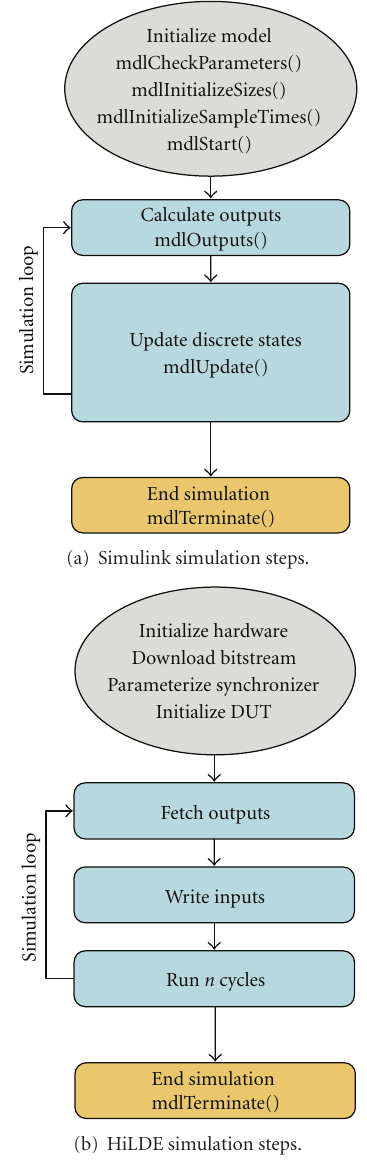
Figure 3: For Hilde simulations the standard Simulink S-Function (a) has been extended